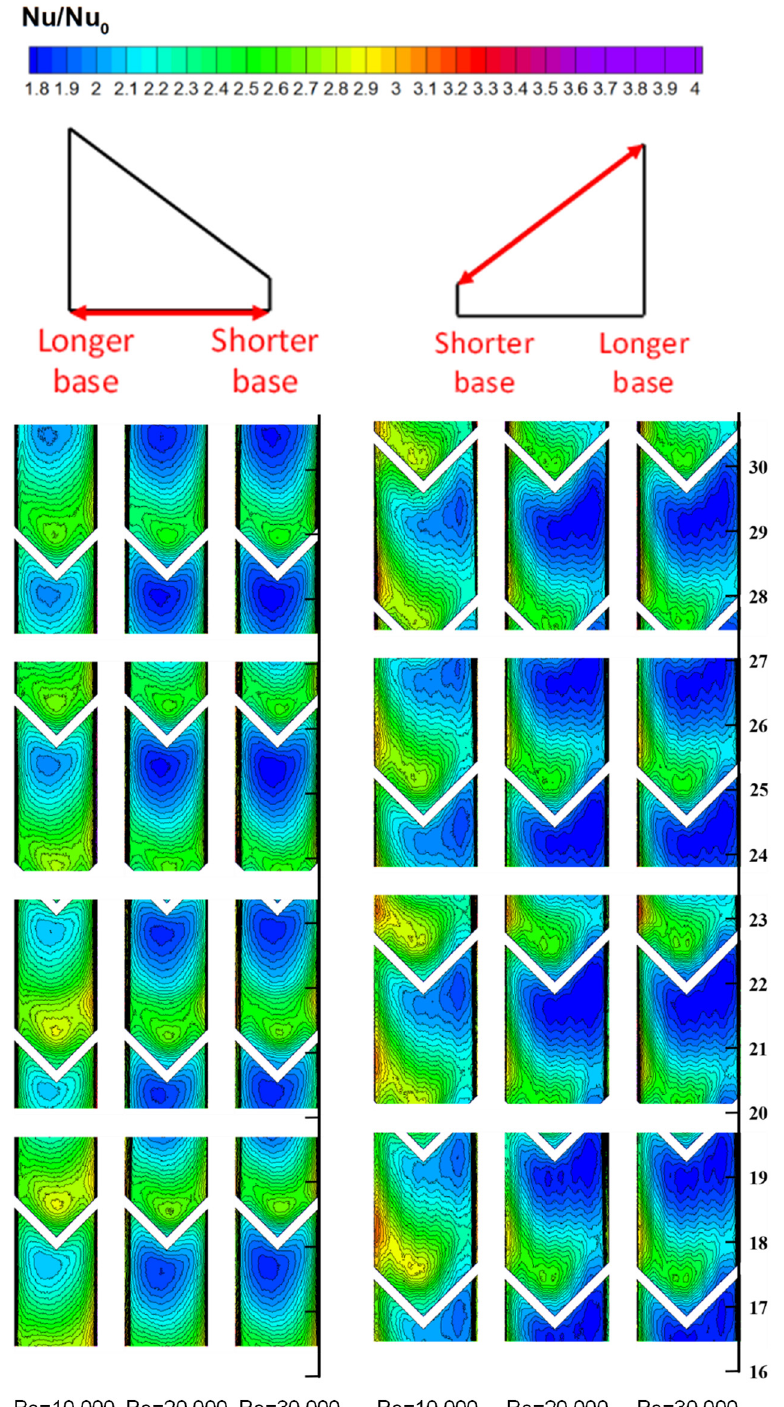
Figure 6. Nusselt number ratios for the V-shaped rib ( P/e = 20).